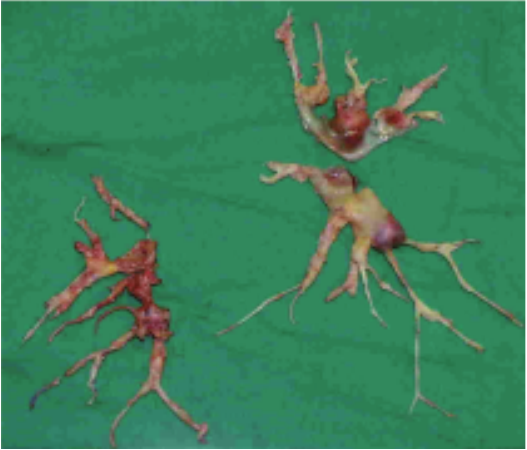
Figure 4 Surgical specimen with intimal thicken- ing and fibrous webs and bands occluding all branches of the left PA and of the right middle and lower lobe